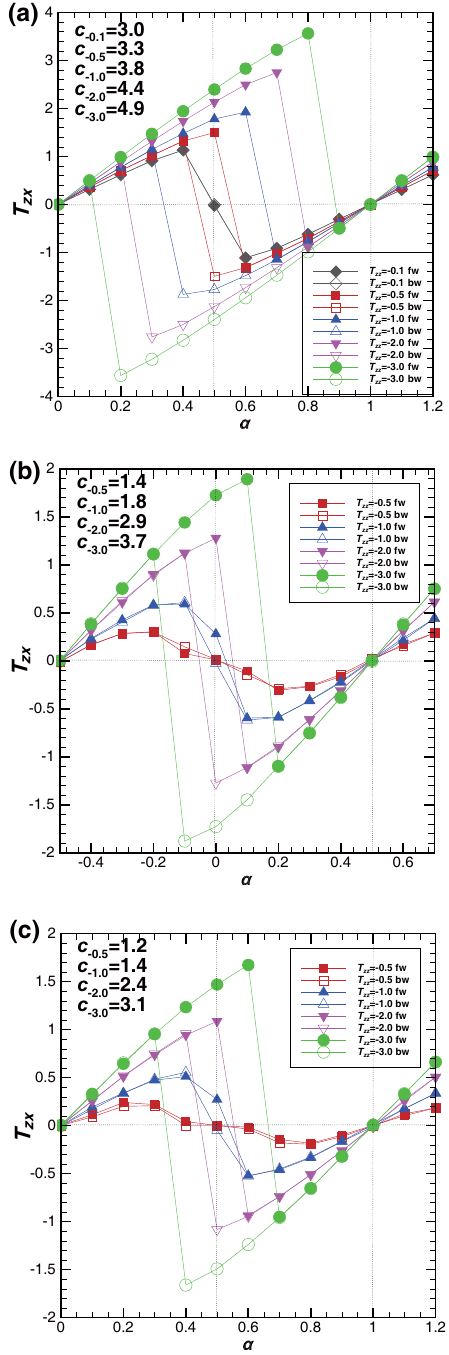
Fig. 11 Shear stress T vs. the  curves under several loads xz T  for (a) the mono-layer, (b) two-layer, and (c) the three-layer zz molecular